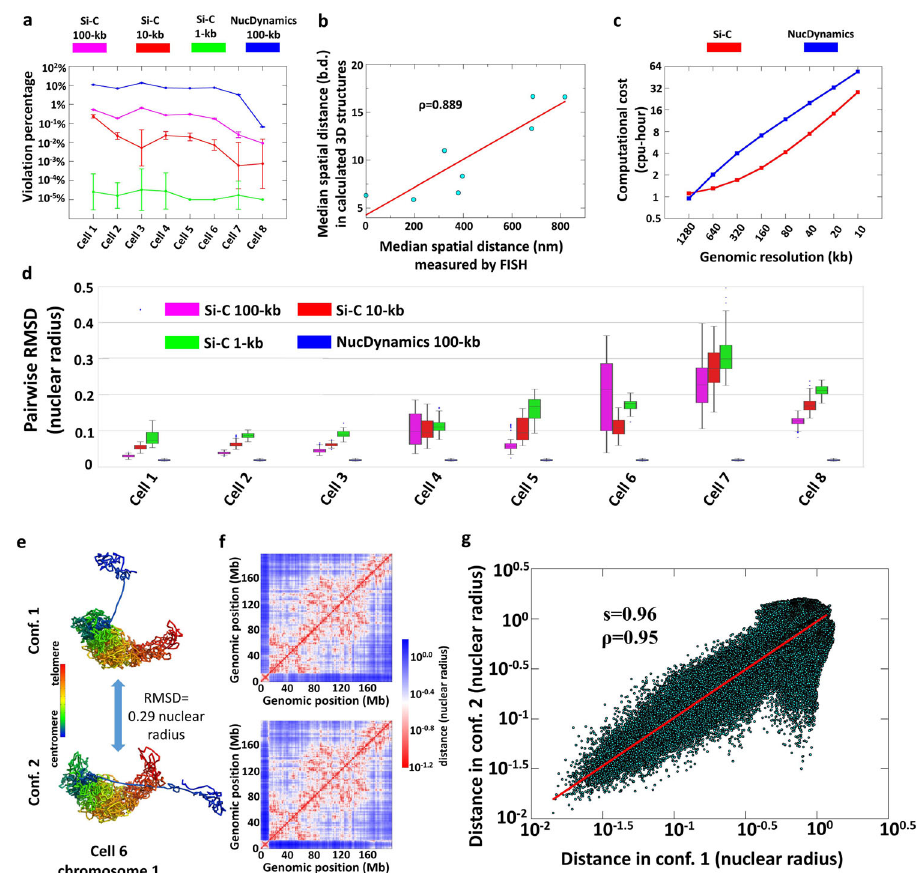
Fig. 2 Estimating the validity and performance of Si-C. a The average percentages of experimental contact restraints violated in the Si-C ensembles at 100 kb (purple), 10 kb (red), and 1 kb (green) resolutions along with the average violation percentages of the published NucDynamics 100-kb structure ensembles of the same cells (blue) (structures downloaded from GEO with accession code GSE80280). The distance threshold to decide whether two beads are in contact set to 2 bead diameters. Data are presented as mean ± SD. For each structure ensemble generated by Si-C, 20 structure replicas are used in the statistical analysis. For structure ensemble downloaded from GEO, ten structure replicas are used. b Correlation between the median spatial distances measured by eight 3D-FISH probe pairs (from ref. 22 ) and the median distances of the corresponding pairs in the Si-C inferred structures of 10 kb resolution. Details for calculating the median spatial distances are shown in Supplement Note 4. c Comparison of Si-C (red) and NucDynamics (blue) in terms of computational cost for structure reconstruction for cell 1. Details are presented in Supplementary Note 3. d Boxplot of pairwise RMSDs within the Si-C ensembles at 100 kb (purple), 10 kb (red), and 1 kb (green) resolutions along with pairwise RMSDs within the published NucDynamics ensembles of the same cells (blue) (structures downloaded from GEO with accession code GSE80280). Median values are shown by black bars. Boxes represent the range from the 25th to the 75th percentile. The whiskers represent 1.5 times the inner quartile range. For each structure ensemble generated by Si-C, 20 structure replicas are used in the statistical analysis. For structure ensemble downloaded from GEO, ten structure replicas are used. e The 10 kb structures of two conformations of chromosome 1 of cell 6 with the RMSD between them of 0.29 nuclear radii. Chromosome regions are colored from blue to red (centromere to telomere). f The distance matrices derived from the two 3D structures shown in e . g Correlation between the two distance matrices in ( f ). The Pearson correlation coef fi cient ( ρ ) is 0.95. The red line is power-law fi t with a scaling exponent (s) equal to 0.96. RMSD root-mean-square Agreement between the experimental and back-calculated data . observed in the population Hi-C matrix (see Fig. 3b). We refer to these domain structures as TAD-like structures and identify their To quantitatively evaluate the agreement between 3D models and boundaries using separation score (details of separation score Hi-C maps, we translated 3D models into distance matrices calculation are presented in Supplementary Note 7). As shown in (details are presented in Supplementary Note 6). For example, we Fig. 3f, the positions corresponding to the separation score peaks constructed the distance matrices for the 10-Mb genomic regions are considered to be boundaries of TAD-like domains. Figure 3e (Chr1: 30 – 40 Mb) based on the Si-C 10-kb structures of the eight shows the positions of TAD boundaries in the population Hi-C individual cells (see Fig. 3a) and averaged them across the eight map, which are identi fi ed by the TopDom algorithm 25 (details for cells to obtain an average distance matrix (see Fig. 3c) that can be TAD boundary identi fi cation are presented in Supplementary compared to the population Hi-C contact-frequency matrix 24 (Fig. 3b; populated Hi-C data downloaded from GEO with Note 7). Comparison between Figs. 3f, e shows that most of the accession code GSE35156). The spatial distance in Fig. 3c displays boundaries of TAD-like structures align with the positions of a high correlation with the Hi-C contact frequency in Fig. 3b, TAD boundaries. These fi ndings demonstrate the signi fi cant with Pearson correlation coef fi cient of − 0.92 (see Fig. 3d). Fur- similarity between the calculated average distance matrix and the thermore, the average distance matrix (see Fig. 3c) shows domain population Hi-C contact-frequency matrix, strongly validating structures similar to topological-associated domains (TADs) the 10-kb resolution structures generated by Si-C.